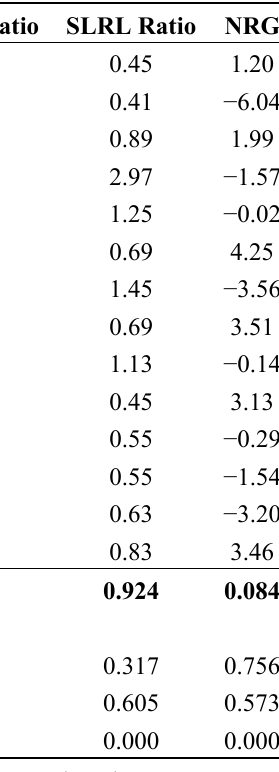
Table 3. Mean performance of maize genotypes averaged across all aluminum concentrations, and probability of main effects and their interaction. Genotype IRL FRL ARL SRL RRL POOL 16